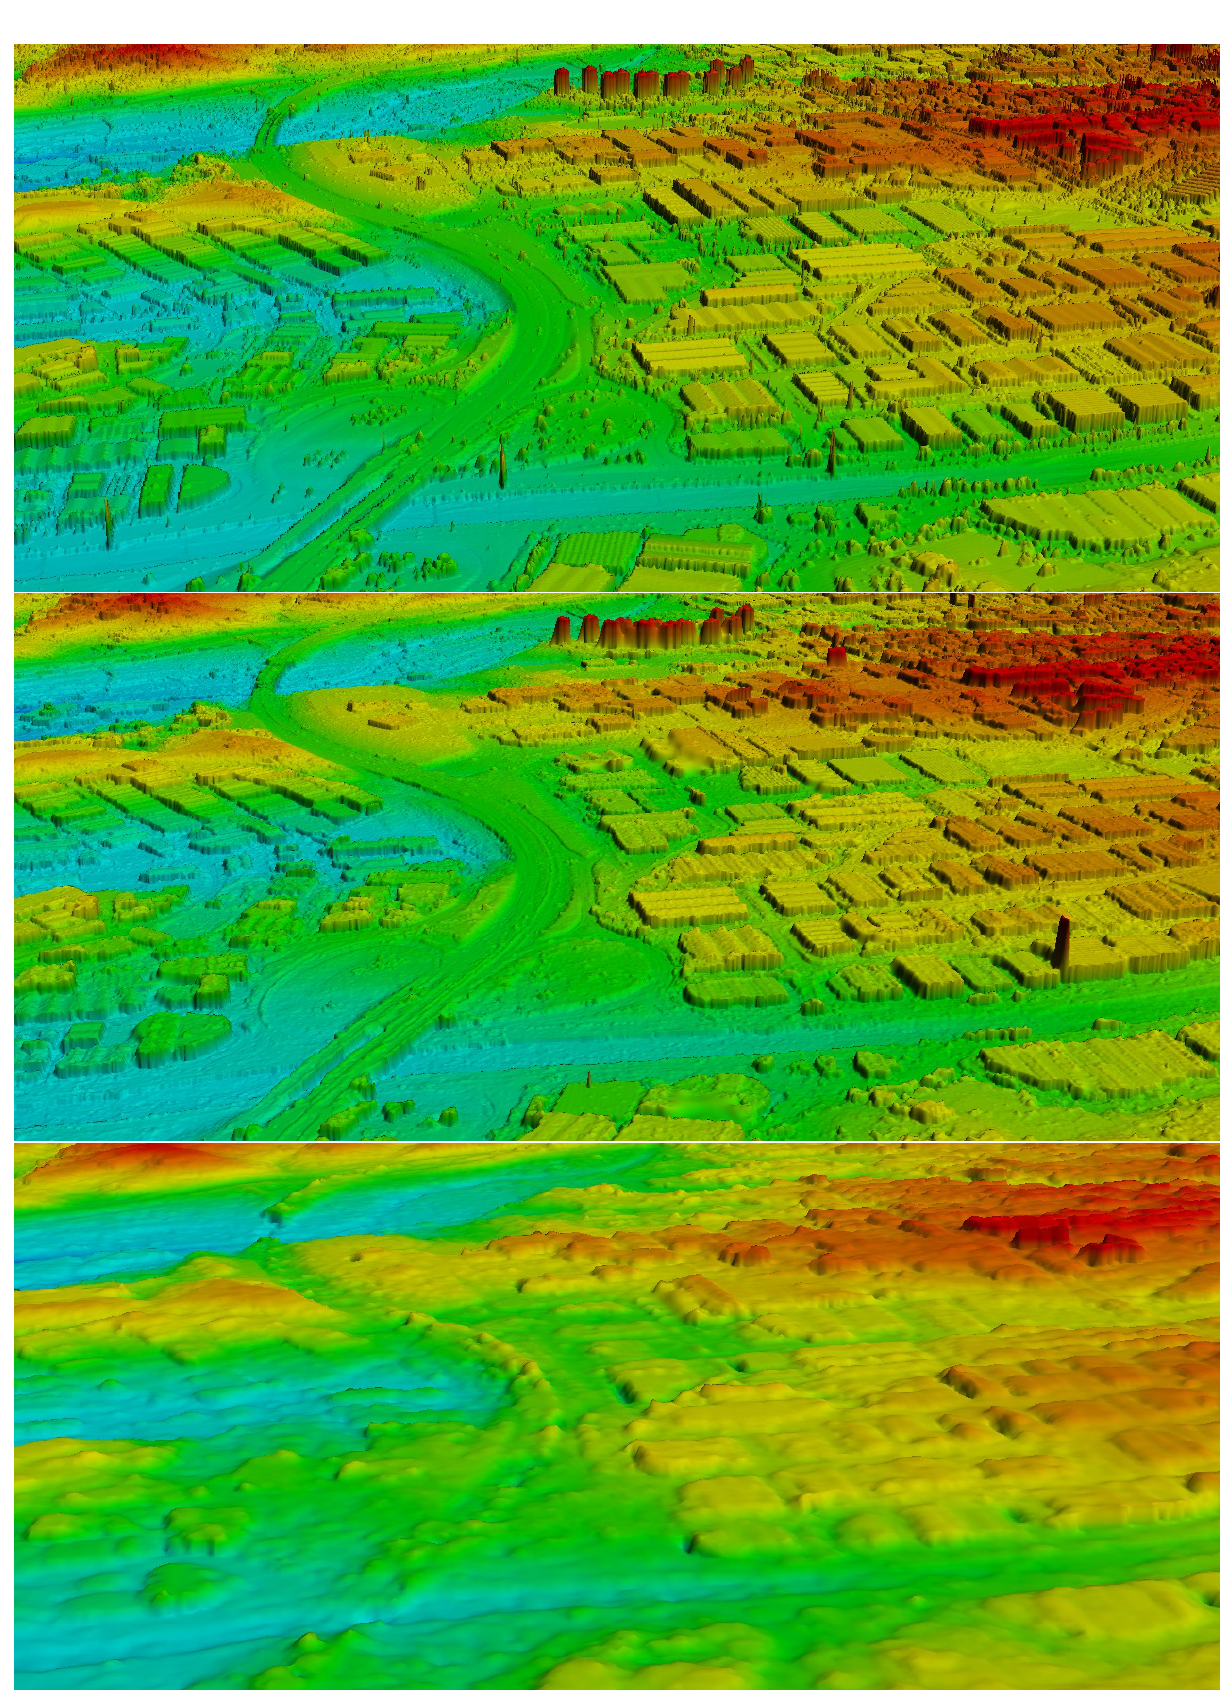
Figure 6: Oblique view on the Terrassa DEMs. The industrial area is located in the foreground of the image. Top to Bottom: 1st Pulse LIDAR (Reference), Worldview-1 DSM, Cartosat-1